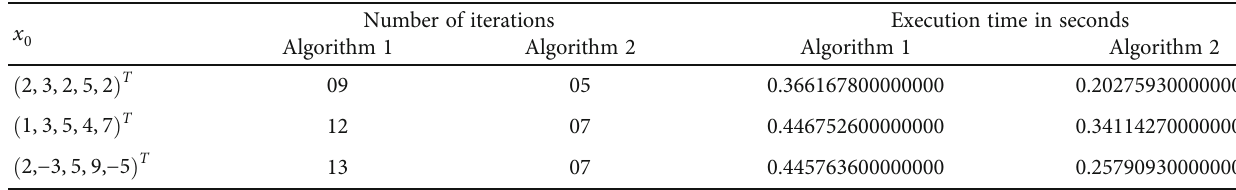
Table 4: All methods ’ numerical values for Figures 9 –